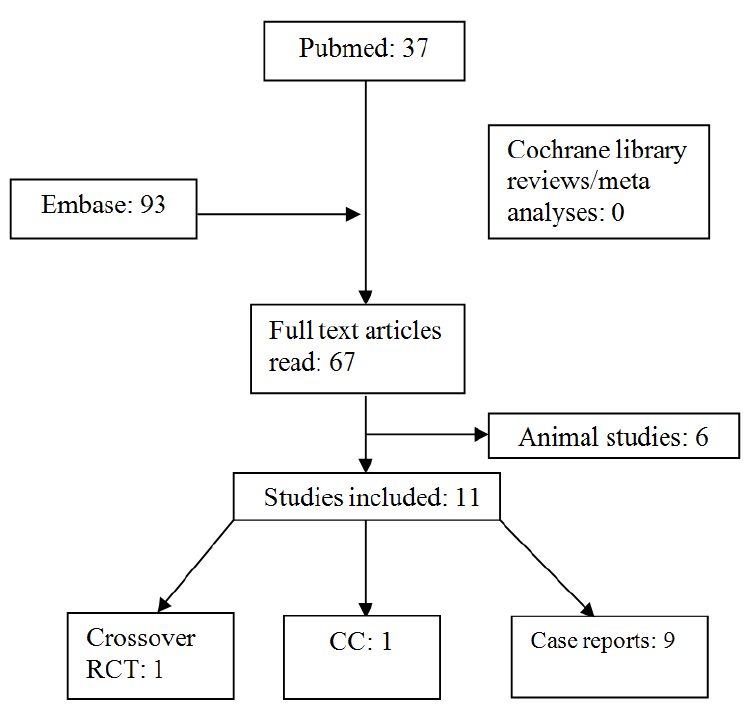
Figure 1. Flow chart of study selection, CC: Case Control